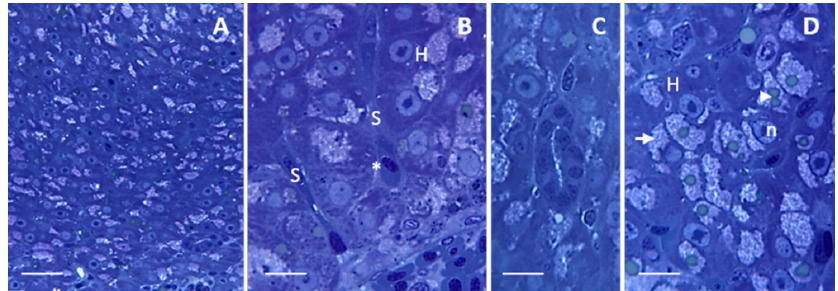
Figure 1. Light micrographs showing Danio rerio liver under control conditions. ( A ) Homogeneous organization of liver parenchyma. Bar 25 μ m; ( B ) Hepatocytes (H) surrounding the sinusoids (S) are disposed in cords. The space of Disse (asterisk) lies between the hepatocytes and the sinusoidal endothelium. Bar 10 μ m; ( C ) Bile duct enclosed by cuboidal epithelium. Bar 10 μ m; ( D ) Hepatocytes contain several (arrowhead) lipid droplets surrounded by numerous glycogen granules (arrow). n =